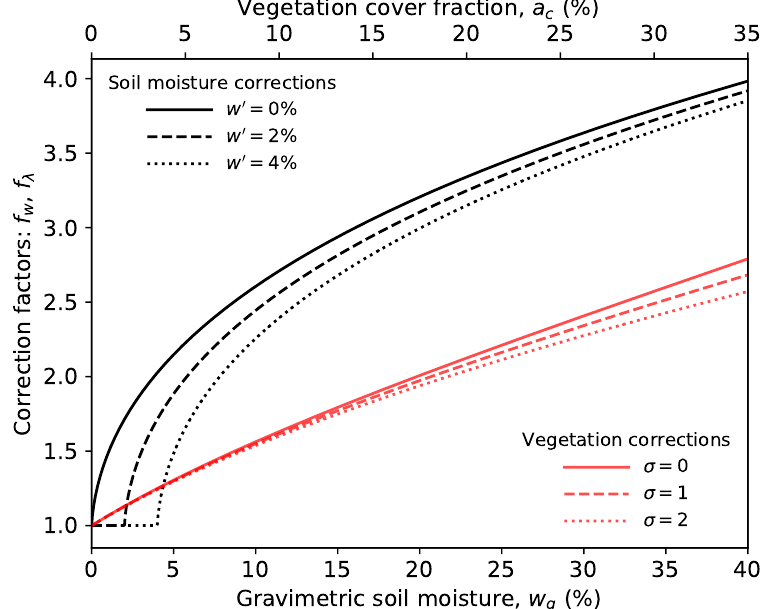
Figure 5. Correction factors for the threshold friction velocity accounting for the effects of soil moisture and vegetation. The factor f w depends on the gravimetric soil moisture, while the factor f λ depends on the vegetation cover fraction. The wind erosion threshold, u ∗ t , is increased due to the effect of both